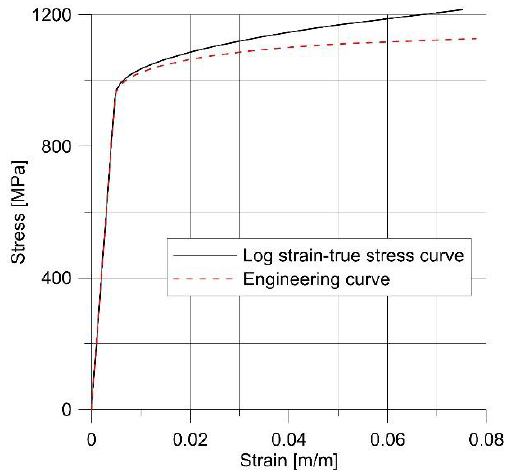
Figure 3. Exemplary fracture locus (source: own simulations).